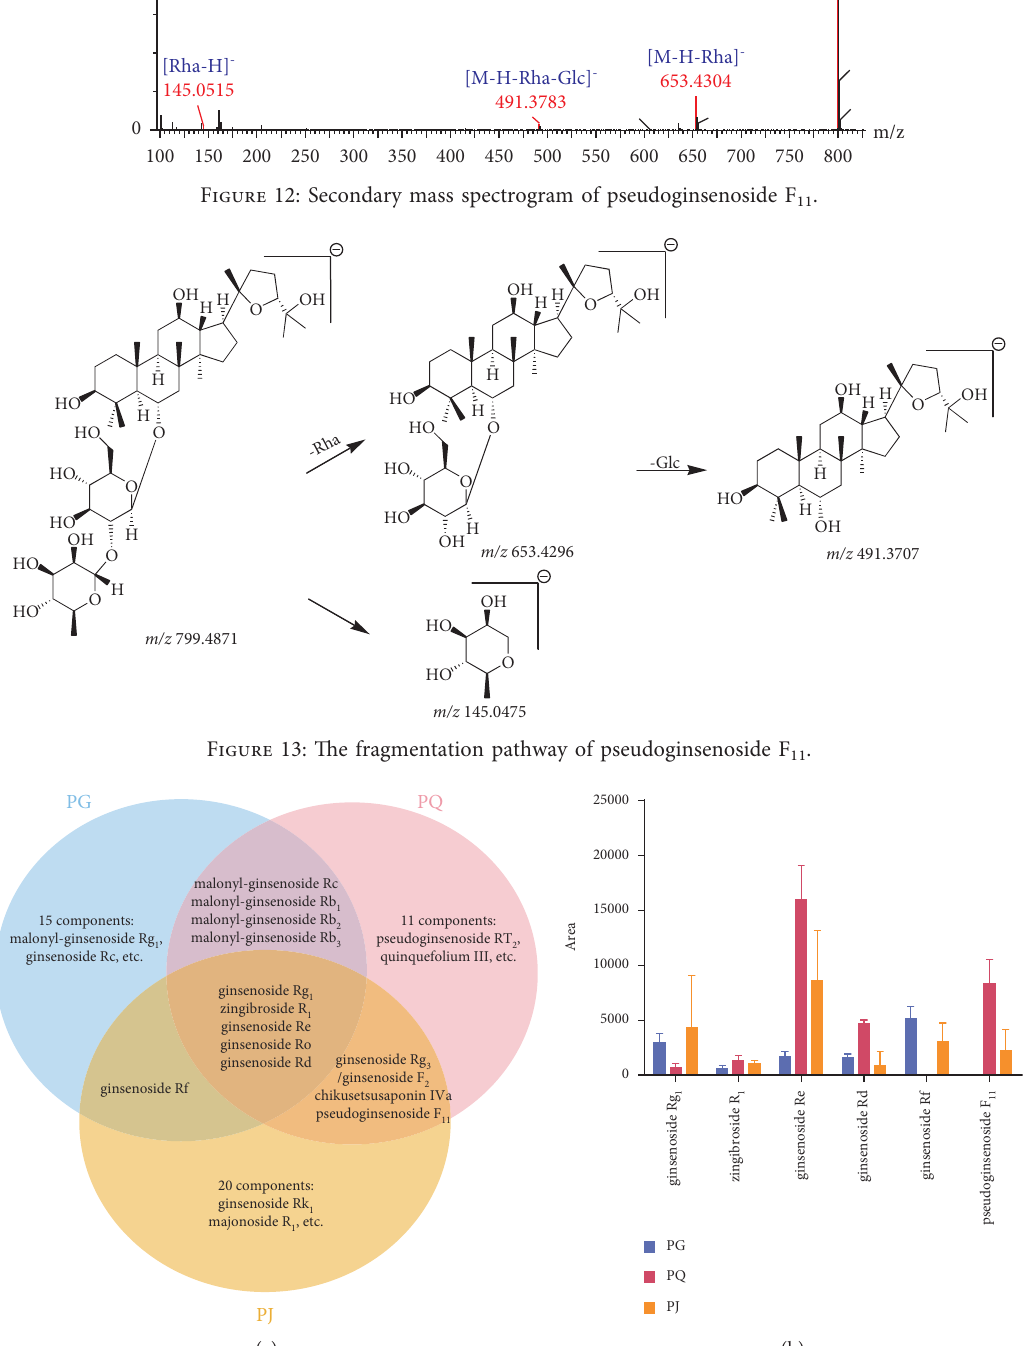
Figure 14: (a) Venn diagram of the distribution of saponins among PG, PQ, and PJ. (b) Contents of six components in PG, PQ, and